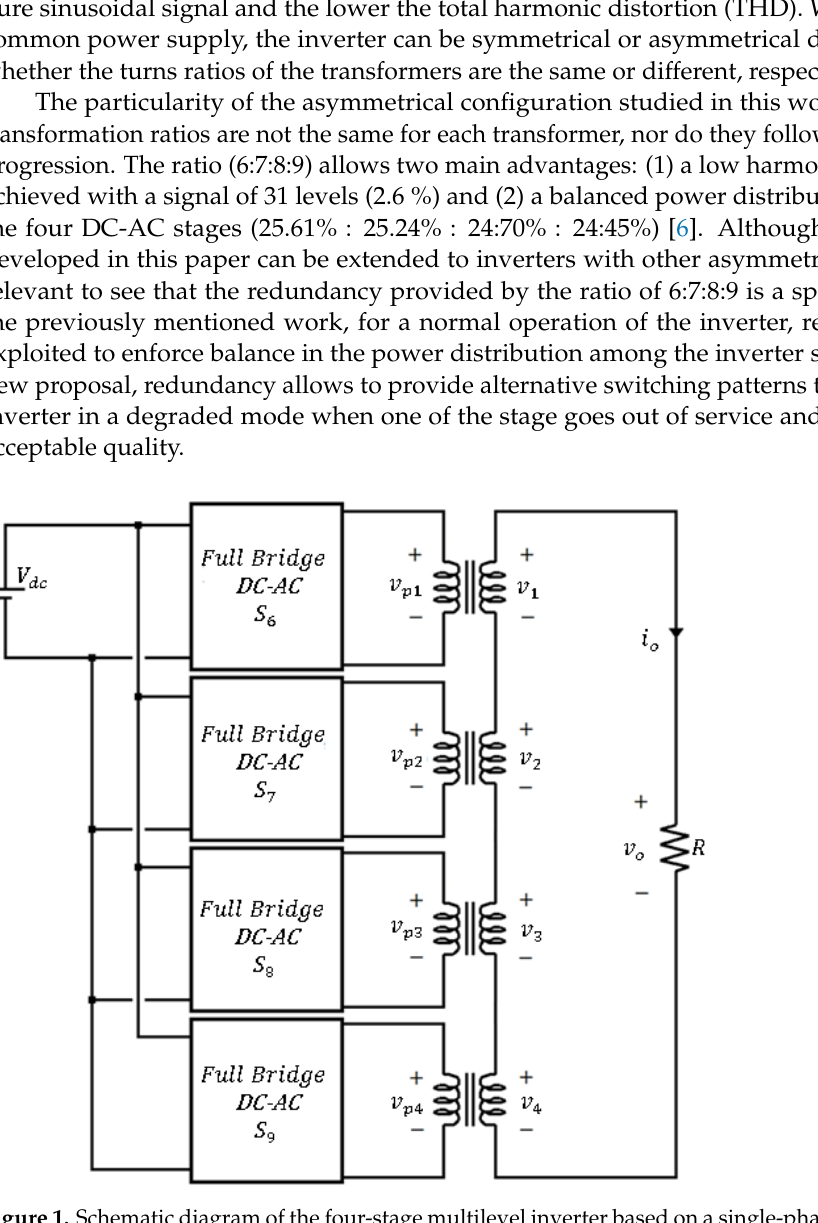
Figure 1. Schematic diagram of the four-stage multilevel inverter based on a single-phase